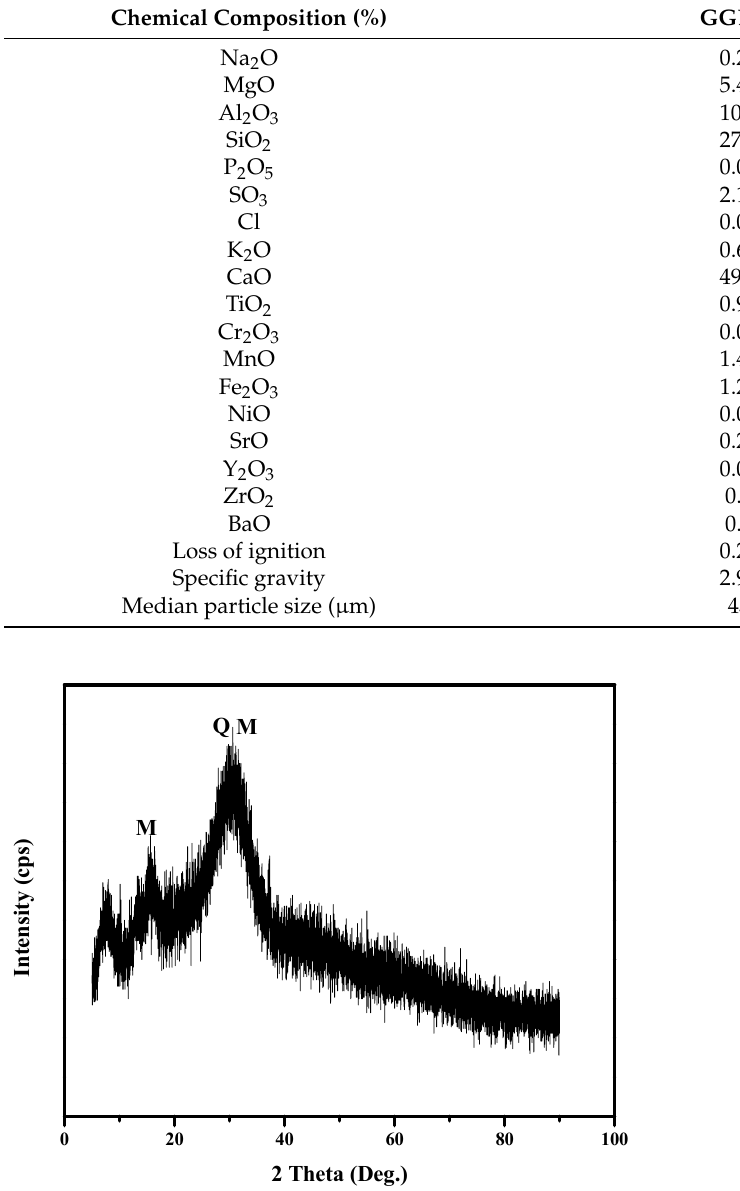
Figure 2. X-ray Diffraction analysis of GGBFS (Q = quartz, M = magnetite). Table 1. Chemical and physical properties of raw GGBFS.